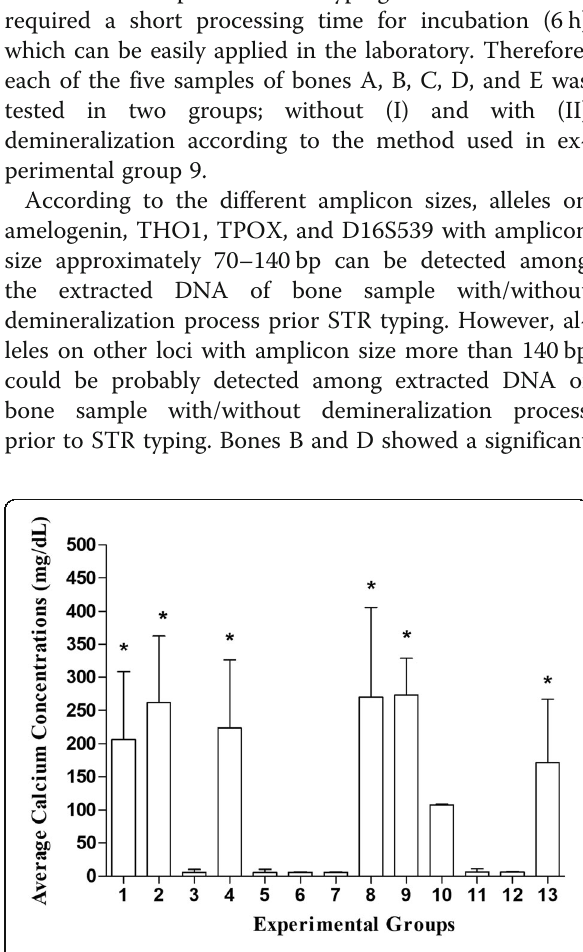
Fig. 2 The calcium level in EDTA solution after the demineralization process. Thirteen experimental groups were varied with different factors. The calcium level chelated from the bone in demineralization buffer after the completed demineralization process was quantified by atomic absorption spectrophotometry. * p value less than 0.05 that